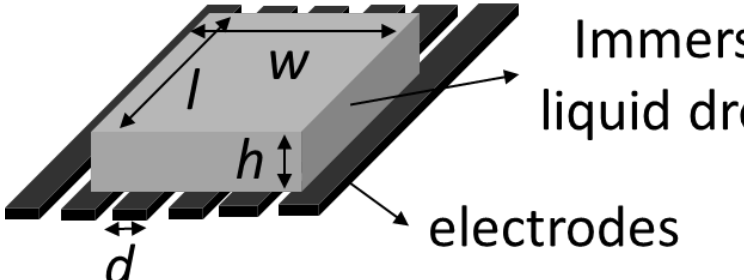
Figure 1. Theoretical analysis of the dielectric model [30].